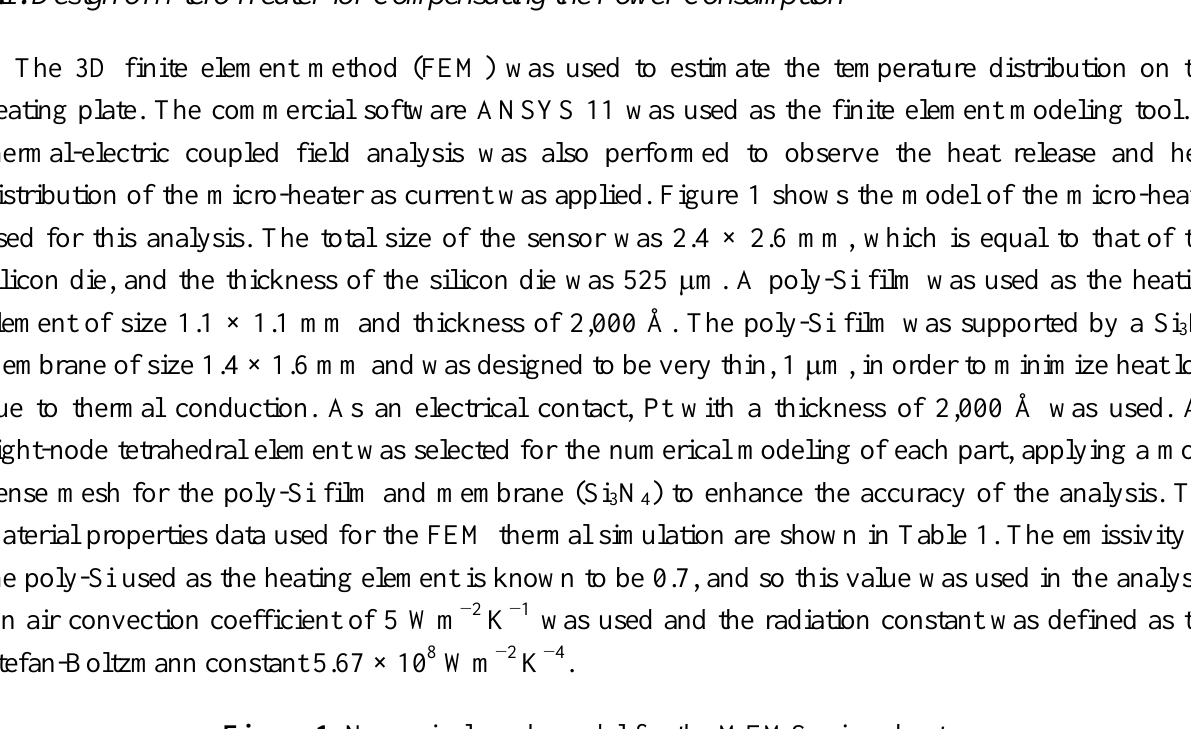
Figure 1. Numerical mesh model for the MEMS